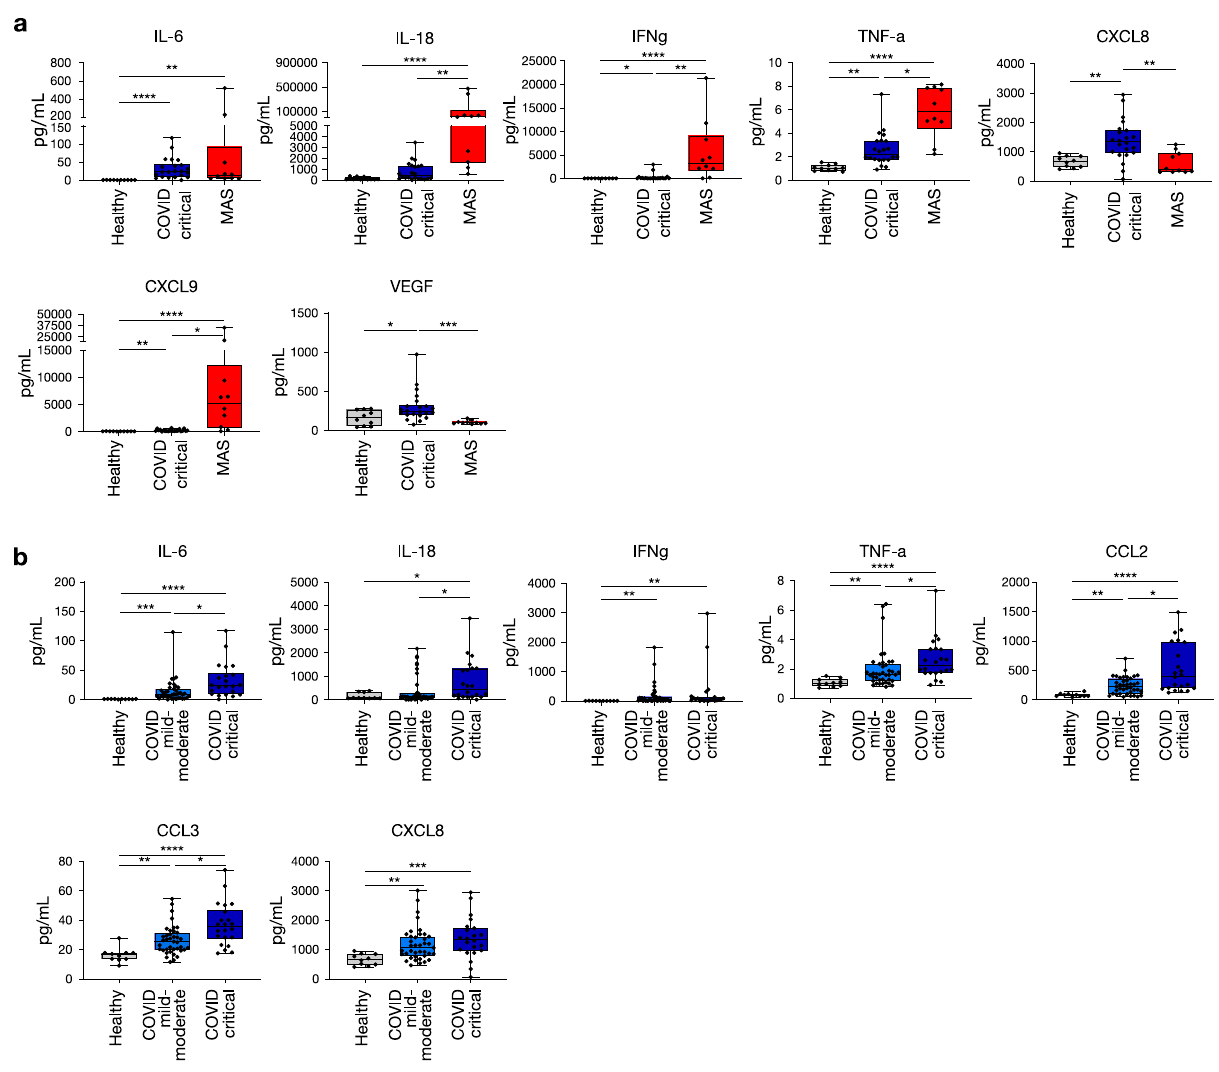
Fig. 1 Hypercytokinemia in COVID-19 as a distinct cytokine release syndrome. Comparison of plasma levels of selected cytokines and chemokines from healthy controls (HC, n = 10), COVID-19 critical condition (CCC, n = 22) and MAS patients ( n = 10) ( a ) and COVID-19 subgroups (for mild-moderate (CMM), n = 39; for critical (CCC), n = 22) versus healthy controls ( n = 10) ( b ). Plasma concentrations were measured by MSD (Meso Scale Discovery). Boxplot representation (centre line, mean; box limits, upper and lower quartiles; whiskers, range; points, data points per patient). A two-sided Kruskal – Wallis test with Dunn ’ s correction for multiple comparisons was used; IL-6: p < 0.0001 HC vs CCC, p = 0.003 HC vs MAS; IL-18: p < 0.0001 HC vs MAS, p = 0.005 CCC vs MAS; IFNg: p = 0.014 HC vs CCC, p < 0.0001 HC vs MAS, p = 0.008 CCC vs MAS; TNF-a: p = 0.004 HC vs CCC, p < 0.0001 HC vs MAS, p = 0.015 CCC vs MAS; CXCL8: p = 0.008 HC vs CCC, p = 0.002 CCC vs MAS; CXCL9: p = 0.007 HC vs CCC, p < 0.0001 HC vs MAS, p = 0.014 CCC vs MAS; VEGF: p = 0.049 HC vs CCC, p = 0.0004 CCC vs MAS ( a ) and IL-6: p = 0.0009 HC vs CMM, p < 0.0001 HC vs CCC, p =